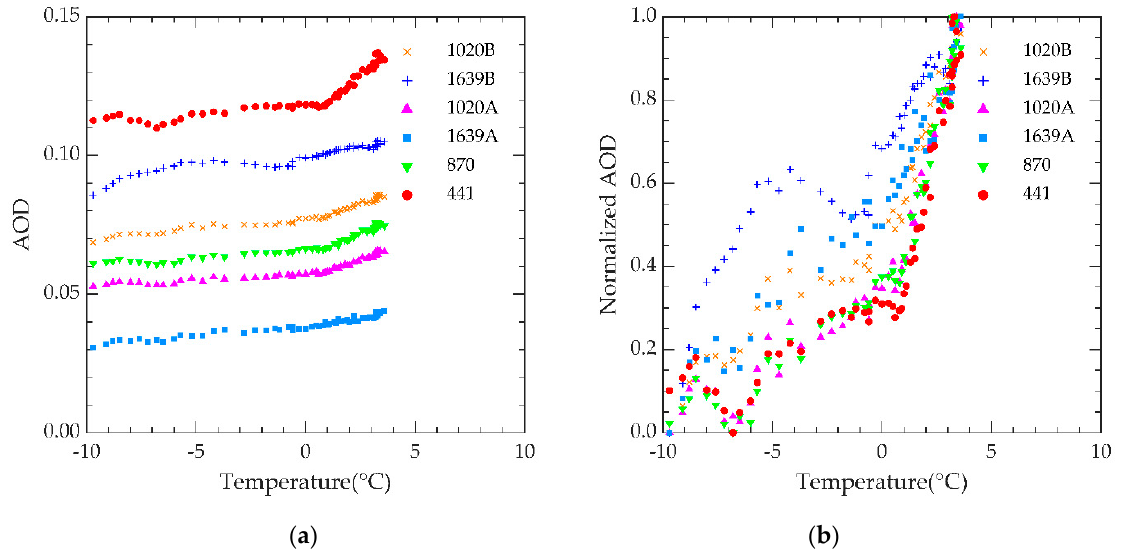
Figure 3. Results of before and after temperature correction on 30 January 2020: ( a ) AOD varying with temperature ( ℃ ); ( b ) normalized AOD varying with temperature ( ℃ ).